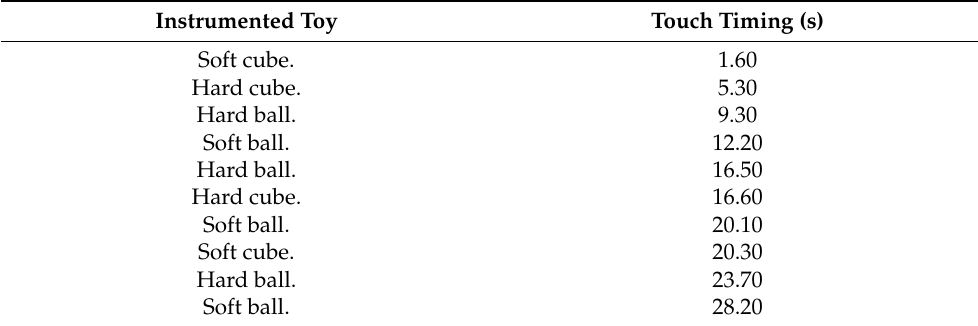
Table 3. Ground truth touch timing and sequence from video coded by a human